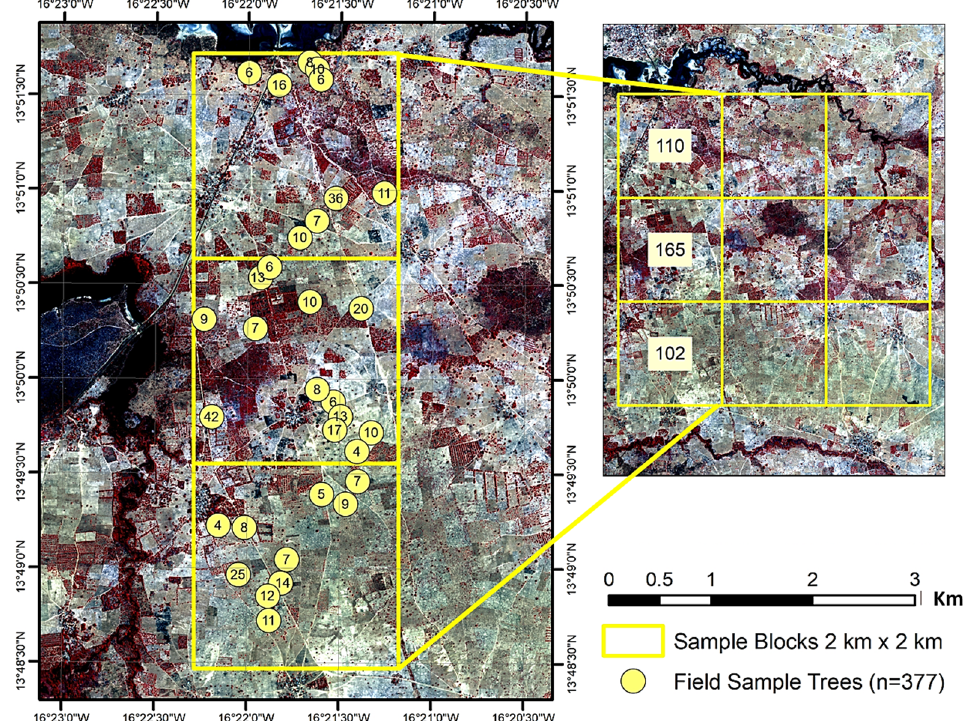
Figure 2. The test site for remote sensing mapping and field data collection. The test site measures 3366 ha in a square area that is divided into nine blocks for field sampling. Field data collection of tree parameters from individual open grown trees outside of forests was conducted along a north–south transect of three blocks. One hectare sample plots were identified and all trees within sample plots were measured. The yellow circles show the location of one or more sample plots and the number of trees sampled.